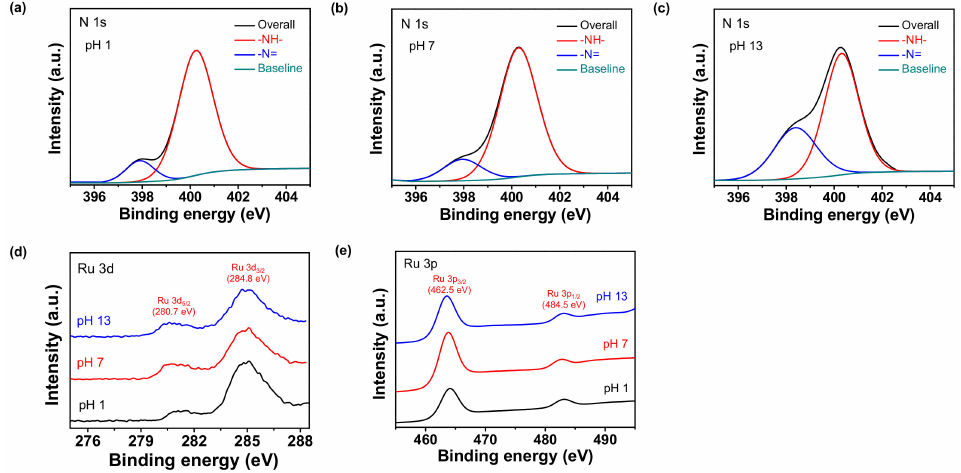
Figure 2. An N 1s high resolution X-ray photoelectron spectroscopy (XPS) analysis of Ru_CPPy with di ff erent pH treatments: ( a ) pH 1; ( b ) pH 7; ( c ) pH 13. ( d ) Ru 3d and ( e ) Ru 3p XPS with diverse pH states (black: pH 1; red: pH 7; blue: pH